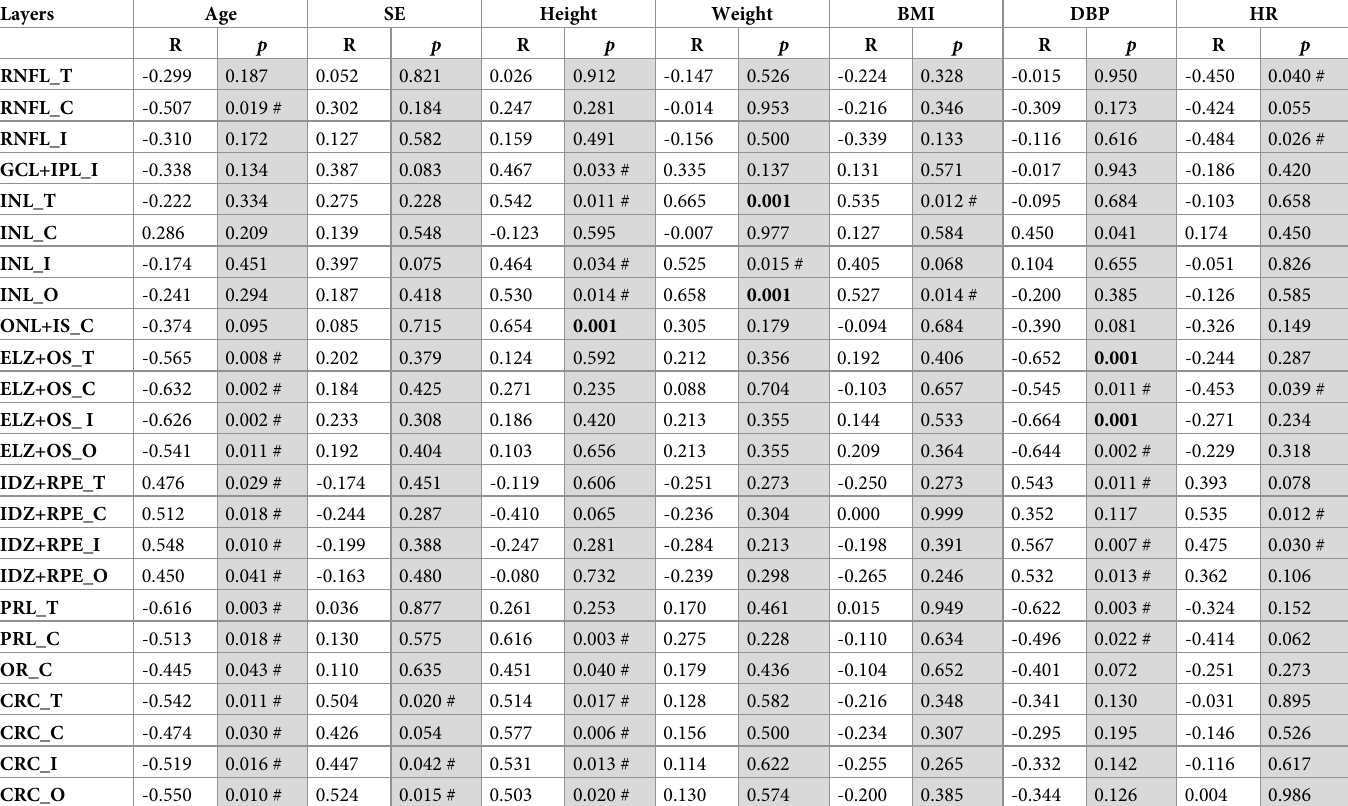
Table 3. Correlations between demographic characteristics and baseline layer thickness values.